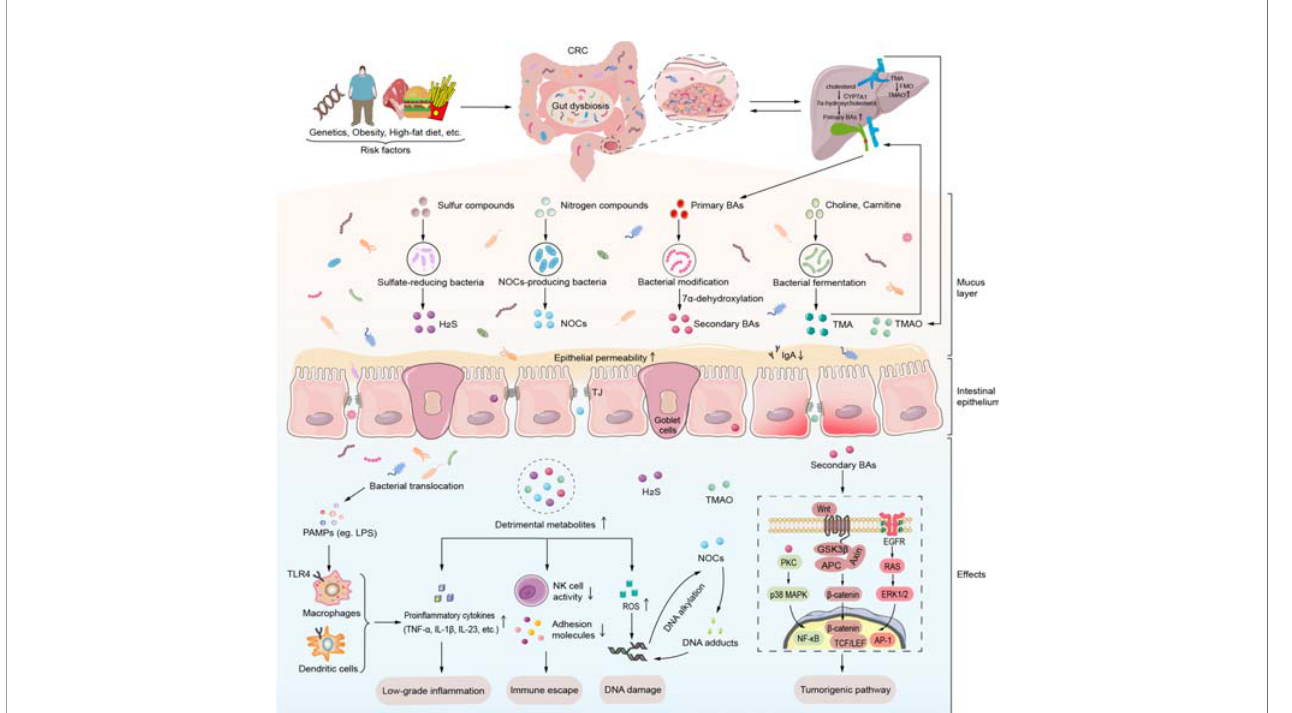
FIGURE 1 | Detrimental gut microbial metabolites induce intestinal carcinogenesis. Various risk factors such as host genetics, obesity, and high-fat diet induce gut microbiota dysbiosis. Alteration of gut microbiota and its metabolites lead to mucus layer thickness reduction, high intestinal permeability and ensuing translocation of commensal microbiota and its metabolites. Male fi cent bacteria overgrowth produces amounts of PAMPs like LPS to recognize the TLR4 of macrophages and dendritic cells, which then release certain proin fl ammatory cytokines (TNF- a , IL-1 b , IL-23, etc.). Moreover, detrimental gut microbiota- derived metabolites such as secondary BAs, TMAO, H 2 S, and NOCs induce carcinogenesis through low-grade in fl ammation, immune escape, DNA damage, and activation of tumorigenic signals. Particularly, secondary BAs contribute to the progression of CRC via speci fi c intracellular transduction pathways such as PKC-p38 MAPK signaling pathway, EGFR-ERK1/2 signaling pathway and Wnt/ b -catenin signaling pathway. In addition to inducing ROS production, NOCs can involve in DNA damage by DNA alkylation and DNA adducts. AP-1, activator protein-1; APC, adenomatous polyposis coli; BAs, bile acids; CRC, colorectal cancer; CYP7A1, cholesterol 7 a hydroxylase; EGFR, epidermal growth factor receptor; ERK1/2, extracellular signal-regulated kinase 1/2; FMO, fl avin monooxygenase; GSK3 b , glycogen synthase kinase 3 b ; H 2 S, hydrogen sul fi de; IL-1 b , interleukin-1 b ; IL-23, interleukin-23; LEF, Lymphatic enhancement factor; LPS, lipopolysaccharide; NF- k B, factor-Kappa B; NOCs, N-nitroso compounds; p38 MAPK, p38 mitogen-activated protein kinase; PAMPs, pathogen- associated molecular patterns; PKC, protein kinase C; ROS, reactive oxygen species; TCF, T cell factor; TJ, tight junctions; TLR, Toll-like receptor; TMA, trimethylamine; TMAO, trimethylamine-N-oxide; TNF- a , tumor necrosis factor- a